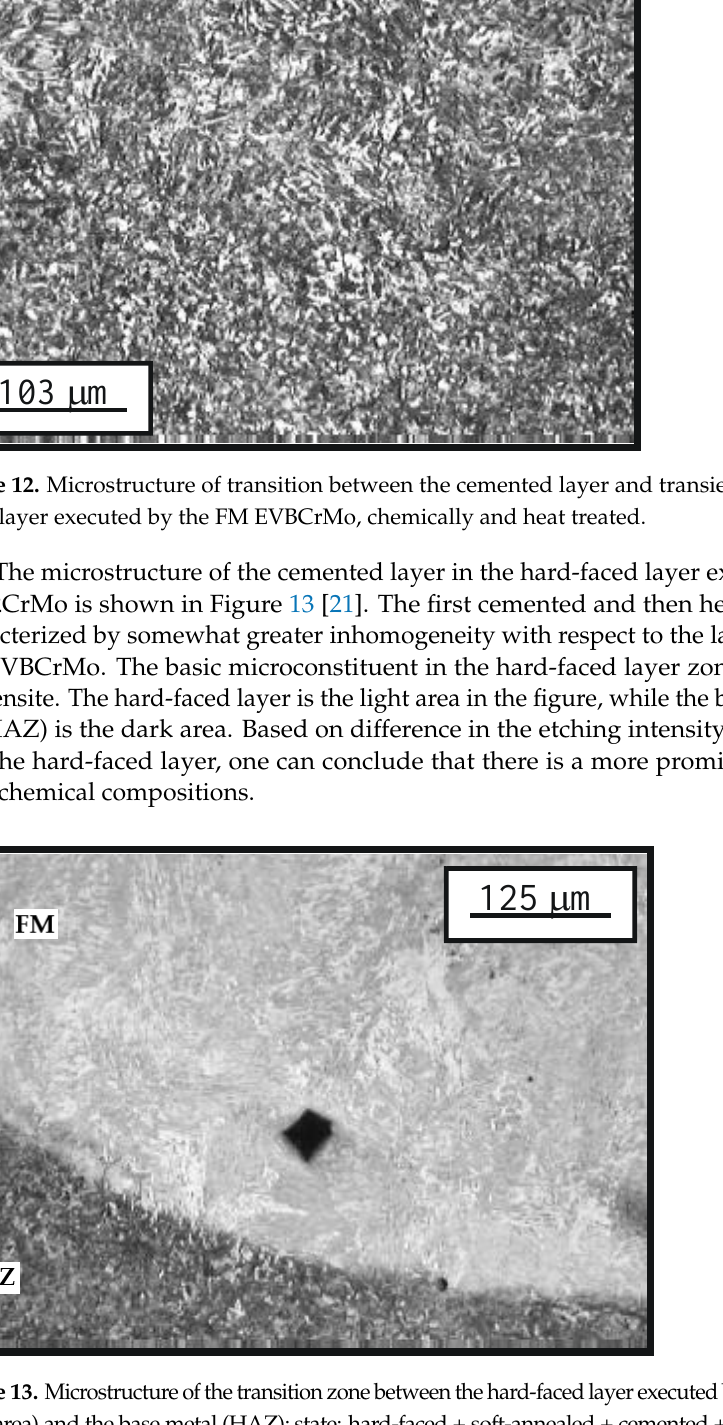
Figure 11. Microstructure of the hard-faced layer executed by the FM Tooldur (light area) and HAZ